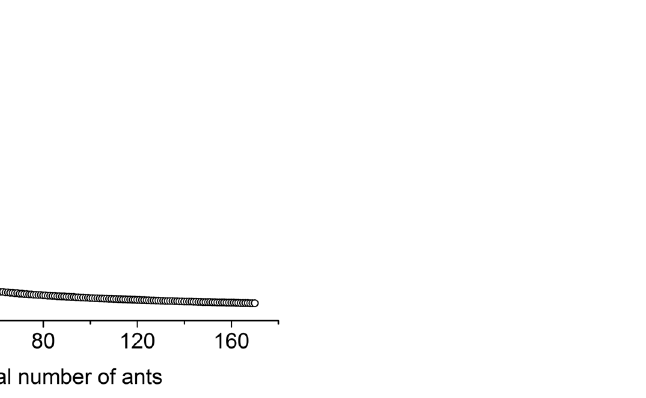
Fig. 1. Random difference produced from random SPP model with respect to the total number of particles.